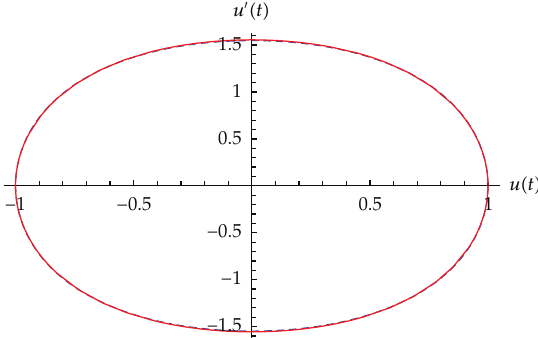
Figure 2: Comparison between the approximate solution (cid:2) 2.34 (cid:3) and numerical results of (cid:2) 2.13 (cid:3) in terms of phase plane in Case a: a (cid:9) b (cid:9) A (cid:9) 1: dashed red line: numerical solution, dashed blue line approximate